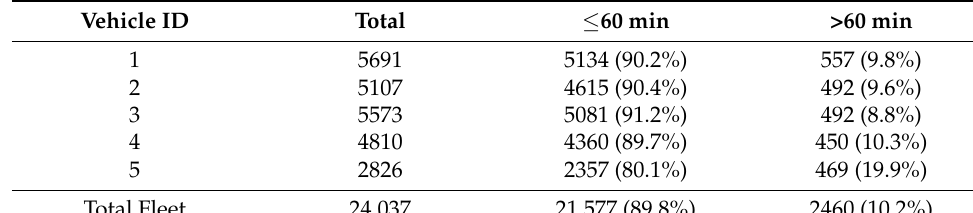
Table 3. Dwell events per vehicle shorter or longer than 60 min.